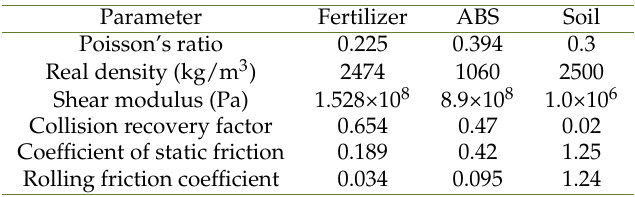
Table 1. Simulation parameter value table.